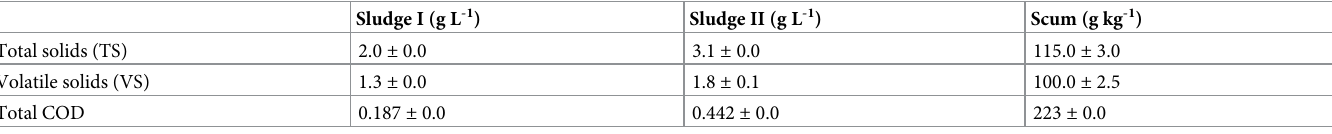
Table 1. Characteristics of sludges and scum.